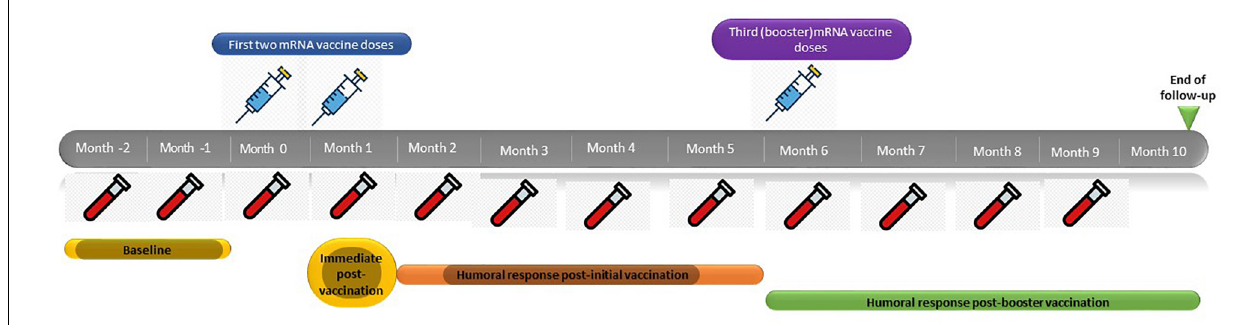
FIGURE 1 | mRNA SARS-CoV-2 vaccine schedule.